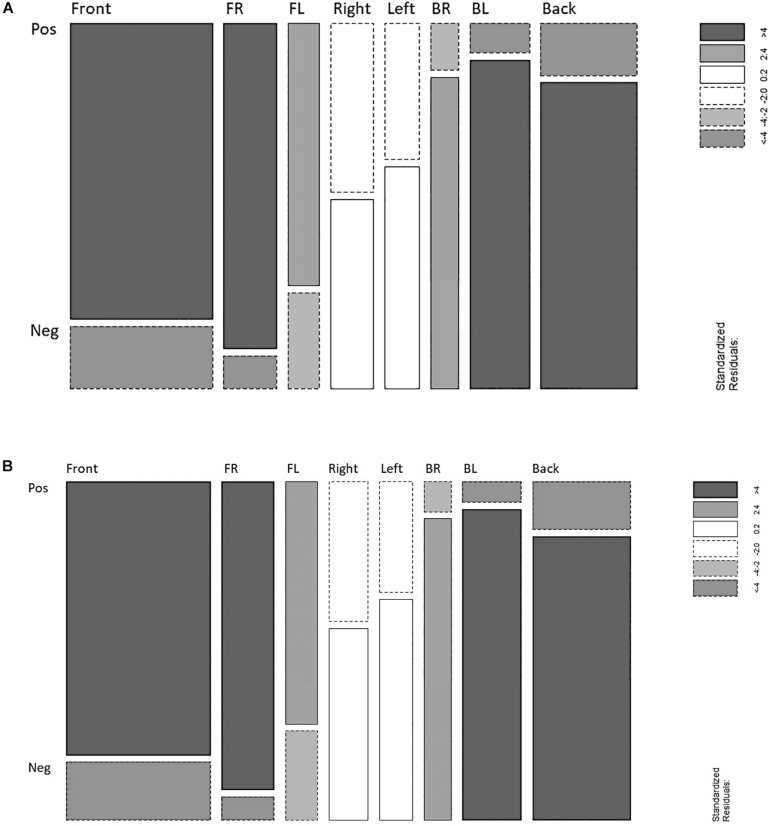
(A) Mosaic plot showing distribution of residuals before the exclusion of extreme observations. (B) Mosaic plot showing distribution of residuals after the exclusion of extreme observations (for further details on mosaic plots see Hartigan and Kleiner, 1984; Friendly, 1994).